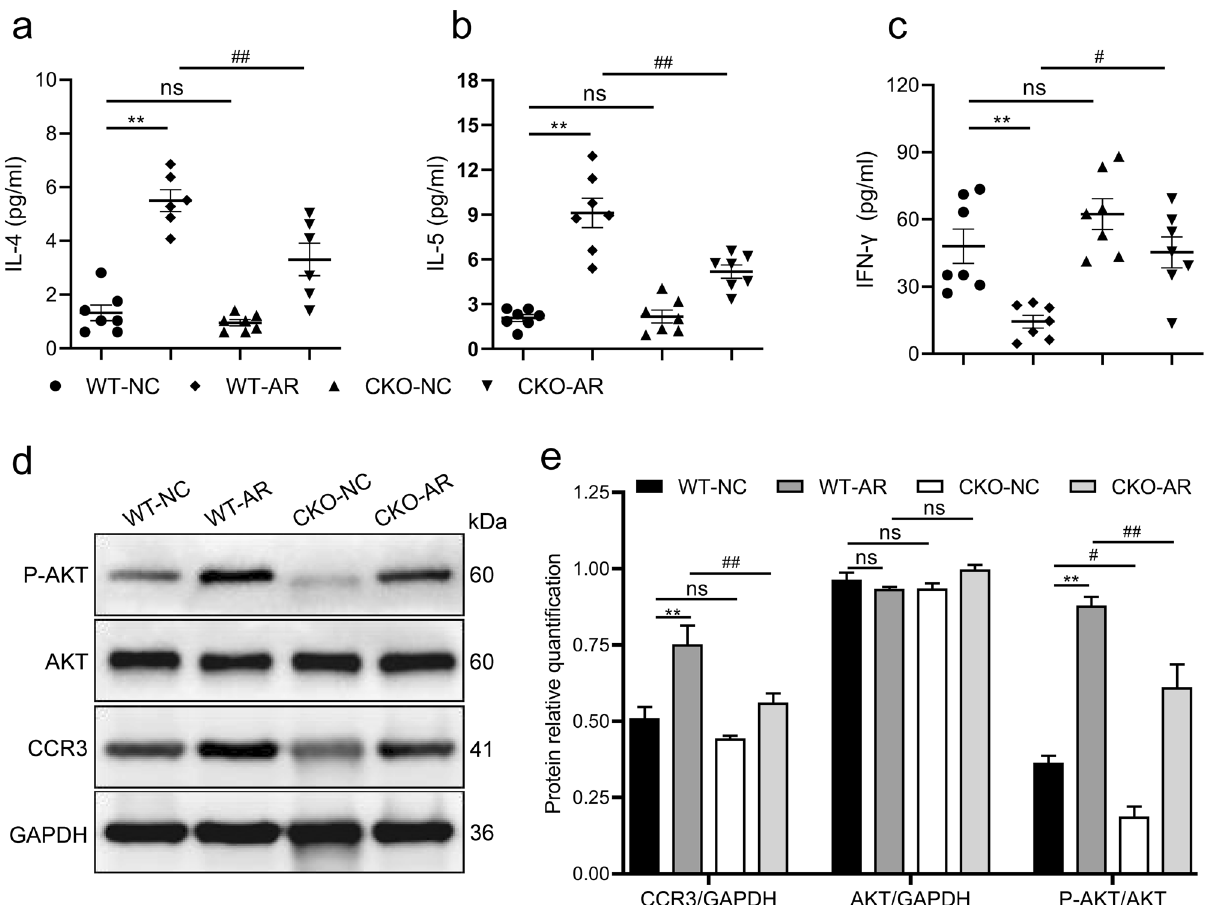
Figure 2. Effects of CCR3 −/− (CKO) on the levels of Th1 and Th2 cytokines and the protein contents of CCR3, AKT and P-AKT. The levels of IL-4 ( a ), IL-5 ( b ) and IFN-γ ( c ) in serum using ELISA. Representative Western blot images ( d ). Relative protein quantifications of CCR3, AKT and P-AKT in the nasal mucosa ( e ). Data are expressed as the means ± SEM. ** P < 0.01 vs. the WT-NC group; # P < 0.05, ## P < 0.01 vs. the WT-AR group, ns indicates P >